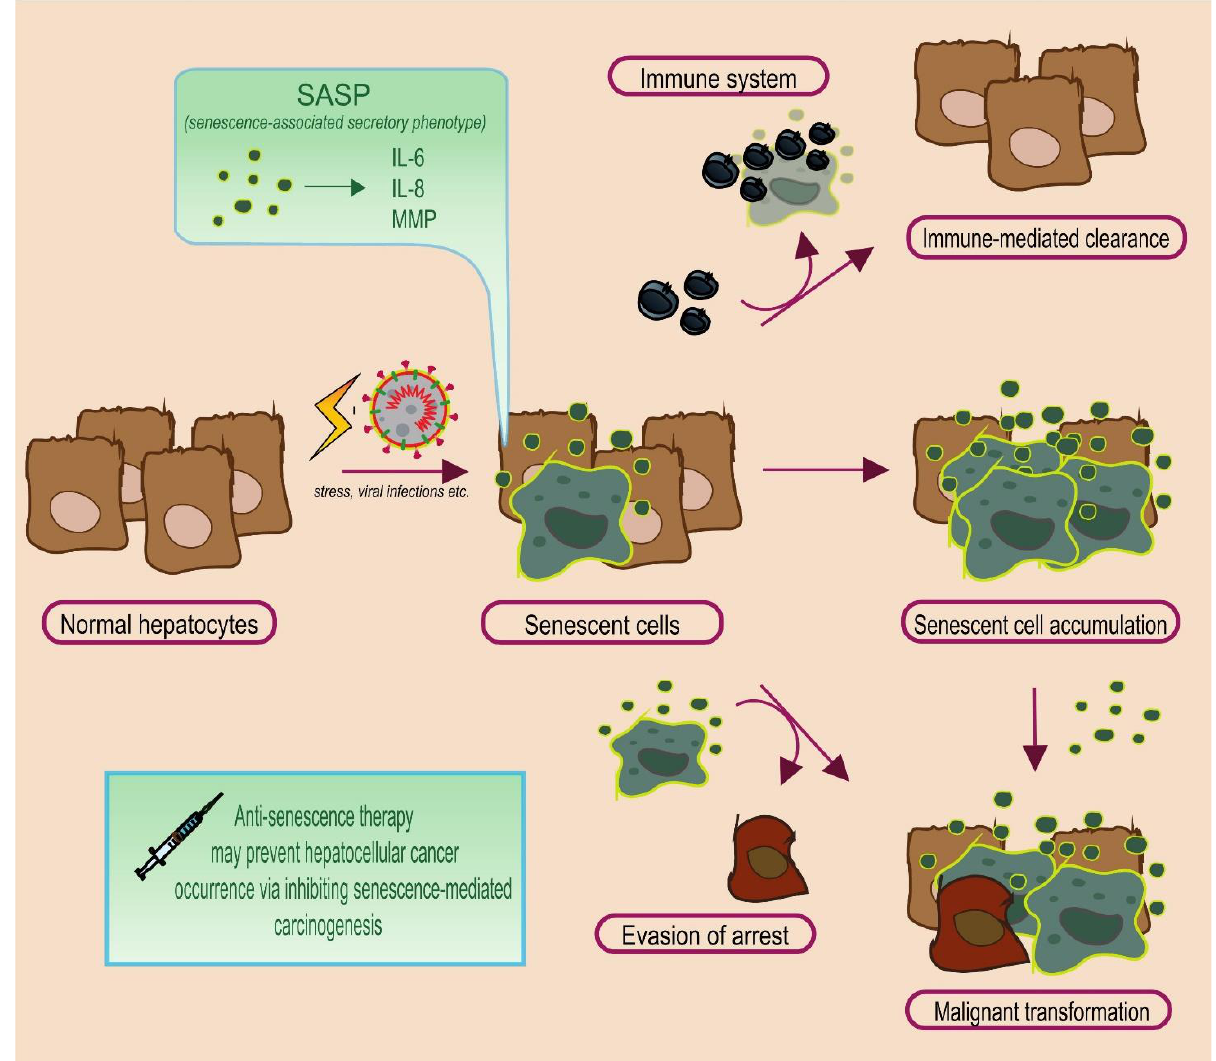
Figure 1. Emergence and fate of senescent hepatocytes. Initially, a stress factor induces cellular damage and triggers the formation of senescent cells. Scenario 1: Activation of the immune system via the senescence-associated secretory phenotype (SASP) and clearance. Scenario 2: Abnormal overt accumulation, SASP secretome activation and carcinogenesis. Scenario 3: Pre-malignant hepatocytes evade senescence arrest and gain proliferative potential, contributing to hepatocellular cancer occurrence. Administering anti-senescence agents may enhance senescent cell elimination and ameliorate their disastrous potential. Normal hepatocytes are presented in pale brown, malignant ones in dark brown, whereas senescent ones are presented in light blue with yellow